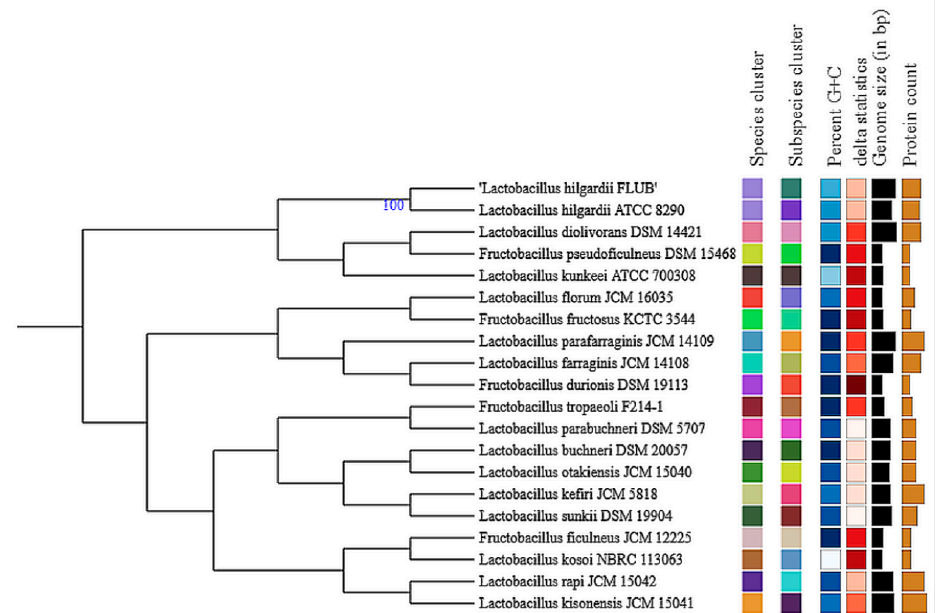
Figure 2. Tree inferred with FastME 2.1.6.1 from GBDP distances calculated from genome sequences. The branch lengths are scaled in terms of GBDP distance formula d5. The numbers above the branches are GBDP pseudo-bootstrap support values >60% from 100 replications, with an average branch support of 16.6%. The tree was rooted at the